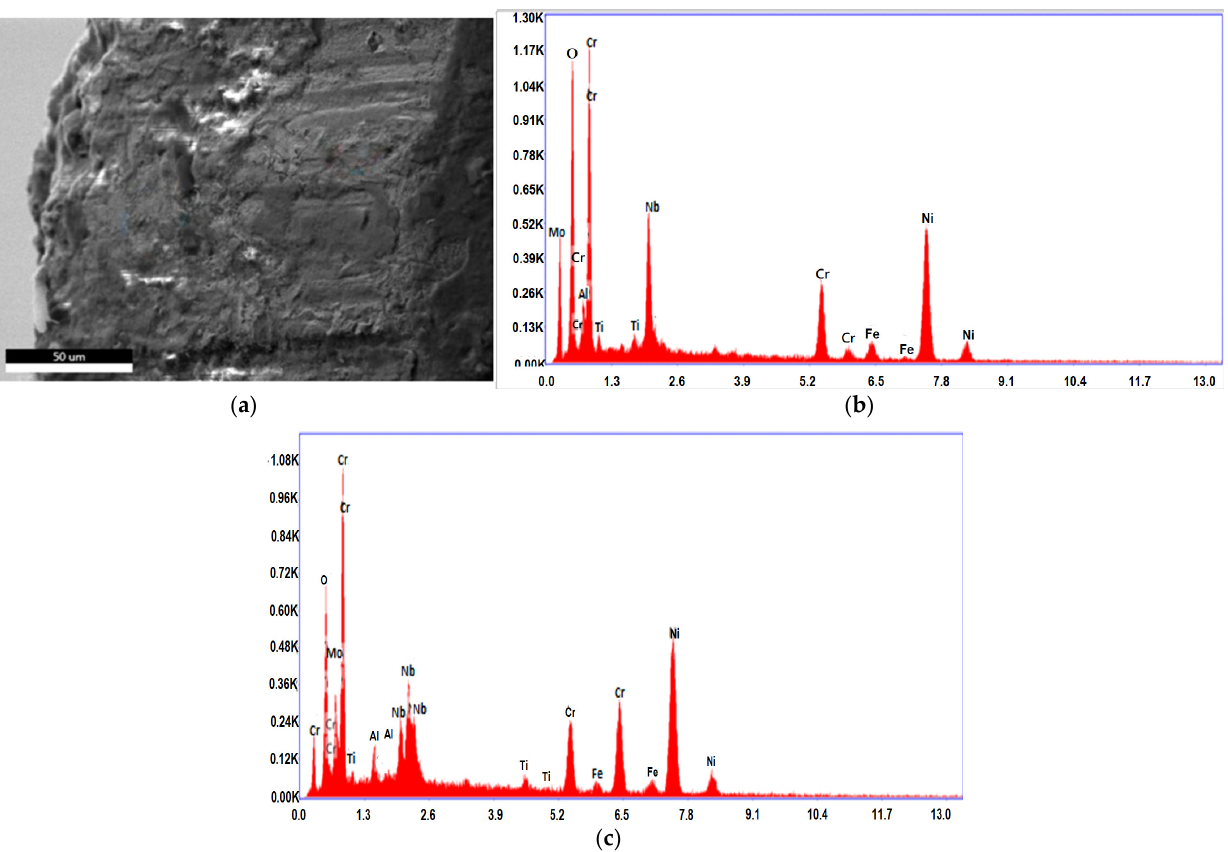
Figure 4. Coated EN8 ( a ) SEM morphology and ( b ) EDS spectrum for isothermal oxidation after 100 h at 1050 °C and ( c ) EDS spectrum at 900 °C.